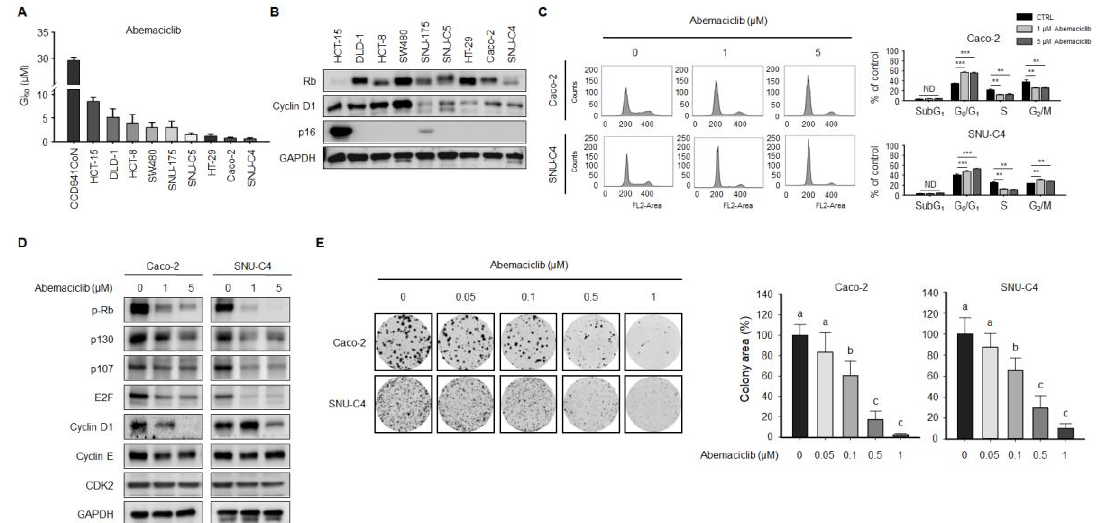
Figure 1. Effect of abemaciclib on cell viability and cell cycle in colon cancer cell lines. ( A ) Cells were exposed to abemaciclib at the indicated concentrations for five days. GI 50 concentrations were calculated using CalcuSyn software. ( B ) The protein expression levels of Rb, cyclin D1, p16, and GAPDH were evaluated in HCT-15, DLD-1, HCT-8, SW480, SNU-176, SNU-C5, HT-29, Caco-2, and SNU-C4 cells. GAPDH was used as a protein-loading control (Figure S1). ( C ) Cell cycle analysis was conducted by FACScalibur after propidium iodide (PI) staining. A total of 2 × 10 6 cells was seeded into 100-mm plates and treated with or without abemaciclib. Data are presented as histograms (black, 0 μM abemaciclib; gray, 1 μM abemaciclib; dark gray, 5 μM abemaciclib.** p < 0.01; and *** p < 0.001. ( D ) Expression levels of p-Rb, p130, p107, E2F, cyclin D1, cyclin E, and CDK2 were determined by western blot. GAPDH was used as a protein-loading control (Figure S1). ( E ) Colony-forming assays were conducted in Caco-2 and SNU-C4 cells. A total of 5 × 10 3 cells was seeded into 6-well plates and treated with abemaciclib for seven days. Colony area was quantified using ImageJ software (National Institutes of Health, Bethesda, MD, USA). Data are expressed as the mean ± S.D. Different letters (a, b, c) indicate significant differences ( p <